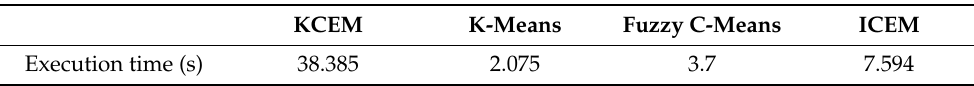
Table 10. Non-mass tumor: Average execution time of each method for 9